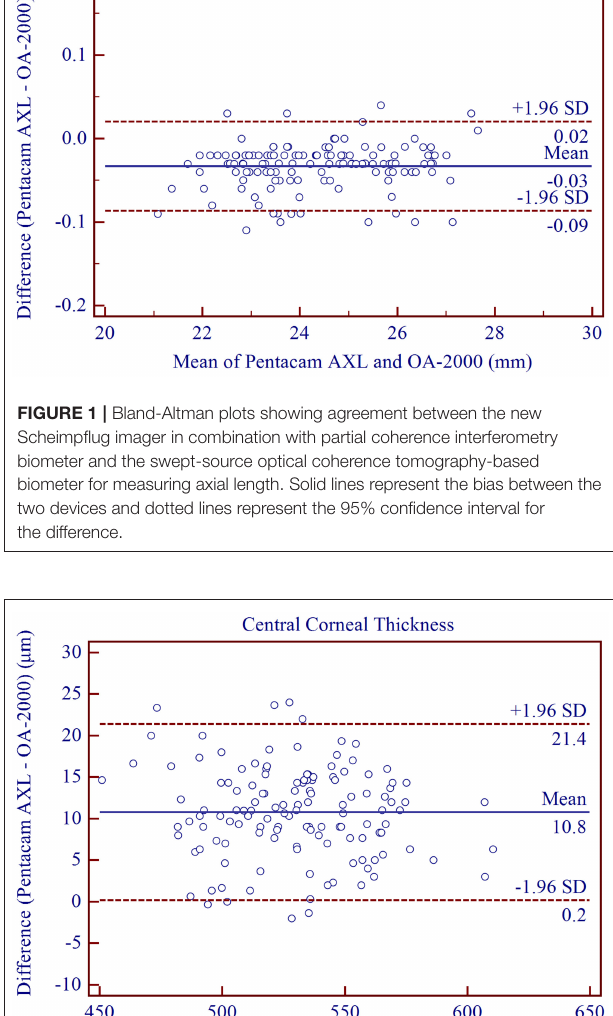
TABLE 3 | The mean difference, paired T-test, and 95% limits of agreement (LoA) for differences between the new Scheimpflug imager in combination with partial coherence interferometry biometer and the swept-source optical coherence tomography-based biometer.